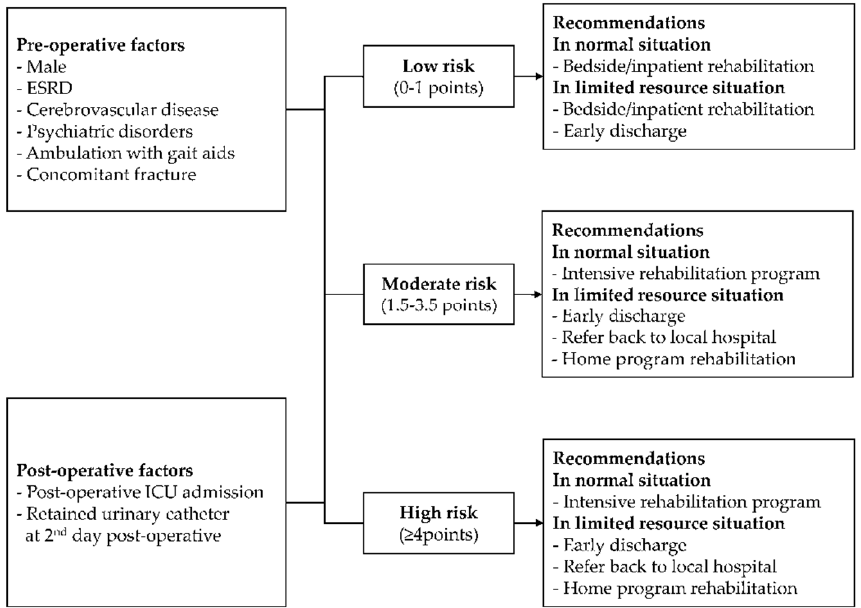
Figure 3. Recommendations for clinical and rehabilitation management according to each patient risk group in regular and limited resource situations.